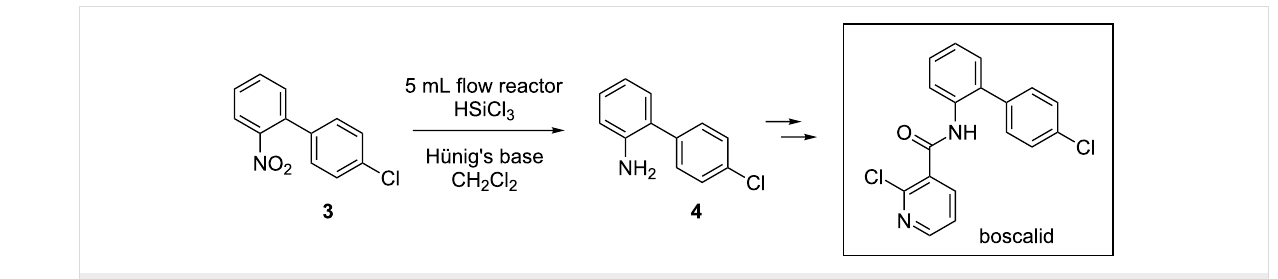
Scheme 4: Synthesis of 2-(4’-chlrophenyl)aniline ( 4 ) with a 5 mL flow reactor.